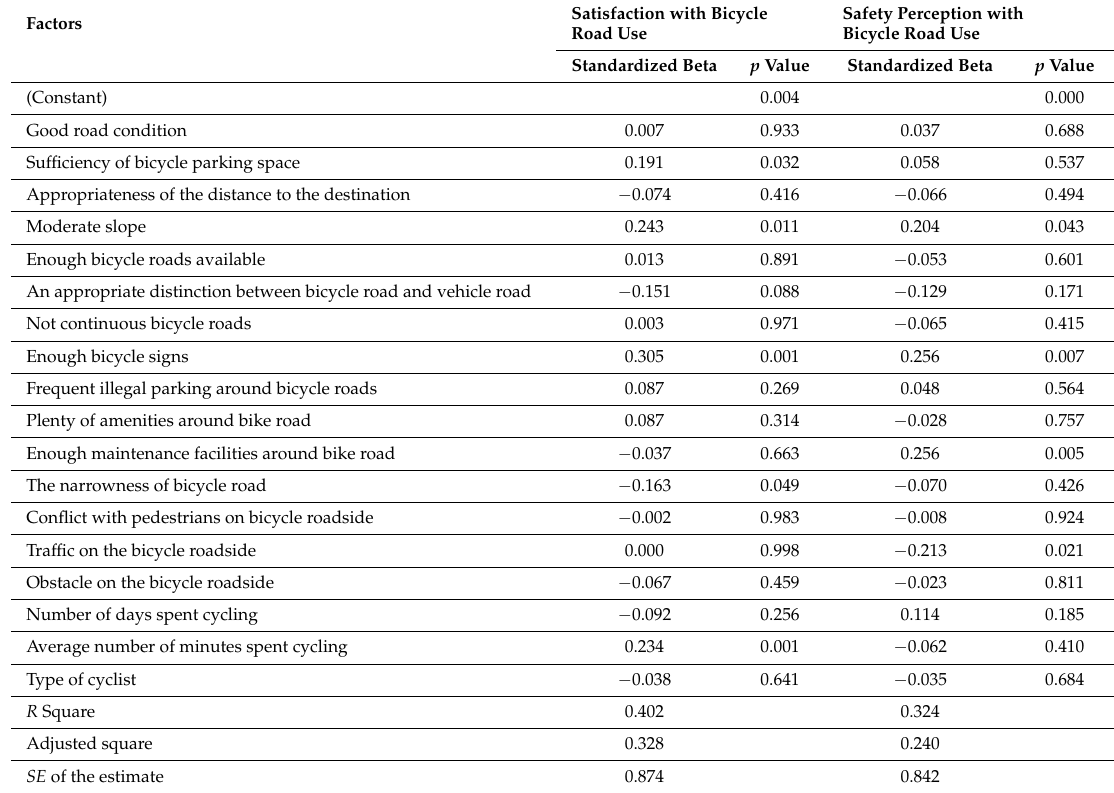
Table 6. Regression analysis of the factors affecting satisfaction and safety perception with the use of bicycle roads in the northwestern part of